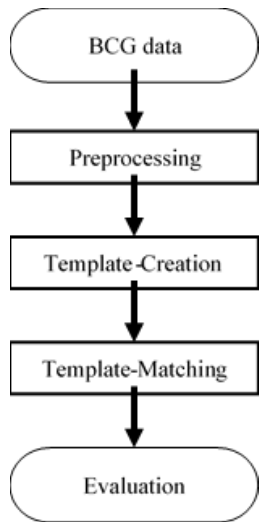
Figure 4. Flowchart of the proposed HRV detection